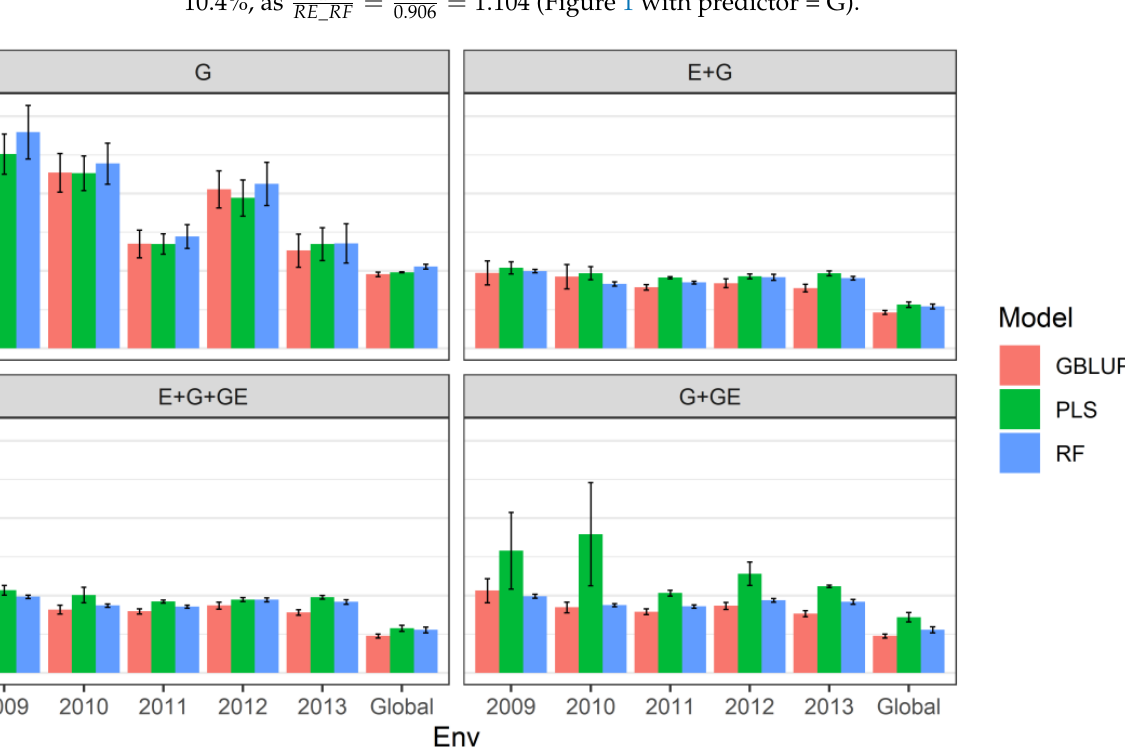
Figure 2. Prediction performance for each environment and across environments (global) of dataset 2 (Japonica) in terms of normalized mean square error (NRMSE) under four predictors (G, genotypic information; E + G, environment plus genotypic information; E + G + GE, environment plus genotypic plus genotype by environment interaction information; and G + GE, genotypic plus genotype by environment interaction) and under the sevenfold cross-validation (CV) scheme. Table 3. Variance components (variance) and heritability’s estimates for Japonica ( dataset 2 ) for each trait. CV denotes the coefficient of variation, and Locs denotes the average number of locations.